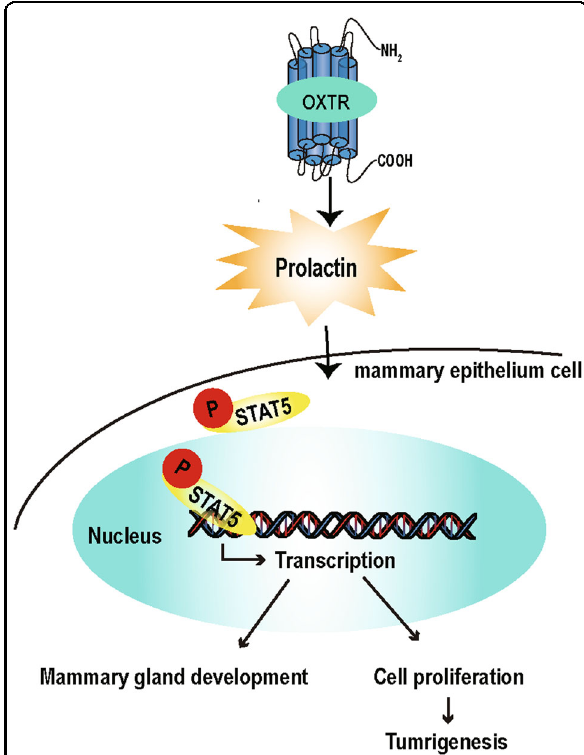
Fig. 7 Role model of OXTR in mammary tumorigenesis. OXTR overexpression leads to increased prolactin secretion in ++ Oxtr females. Prolactin induces phosphorylation and nuclear translocation of p-STAT5 to promote transcription of genes responsible for cell proliferation and milk proteins ( Csn2 and Wap ). Excessive proliferation of mammary epithelium induces